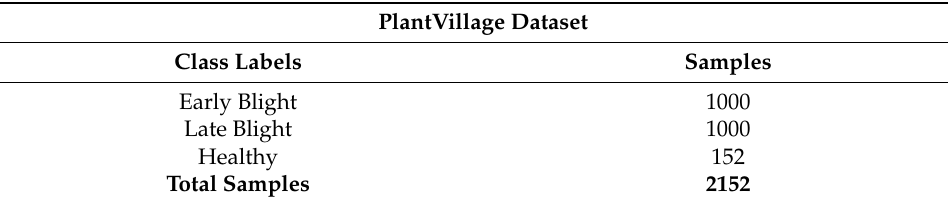
Table 2. Summary of the PlantVillage dataset.